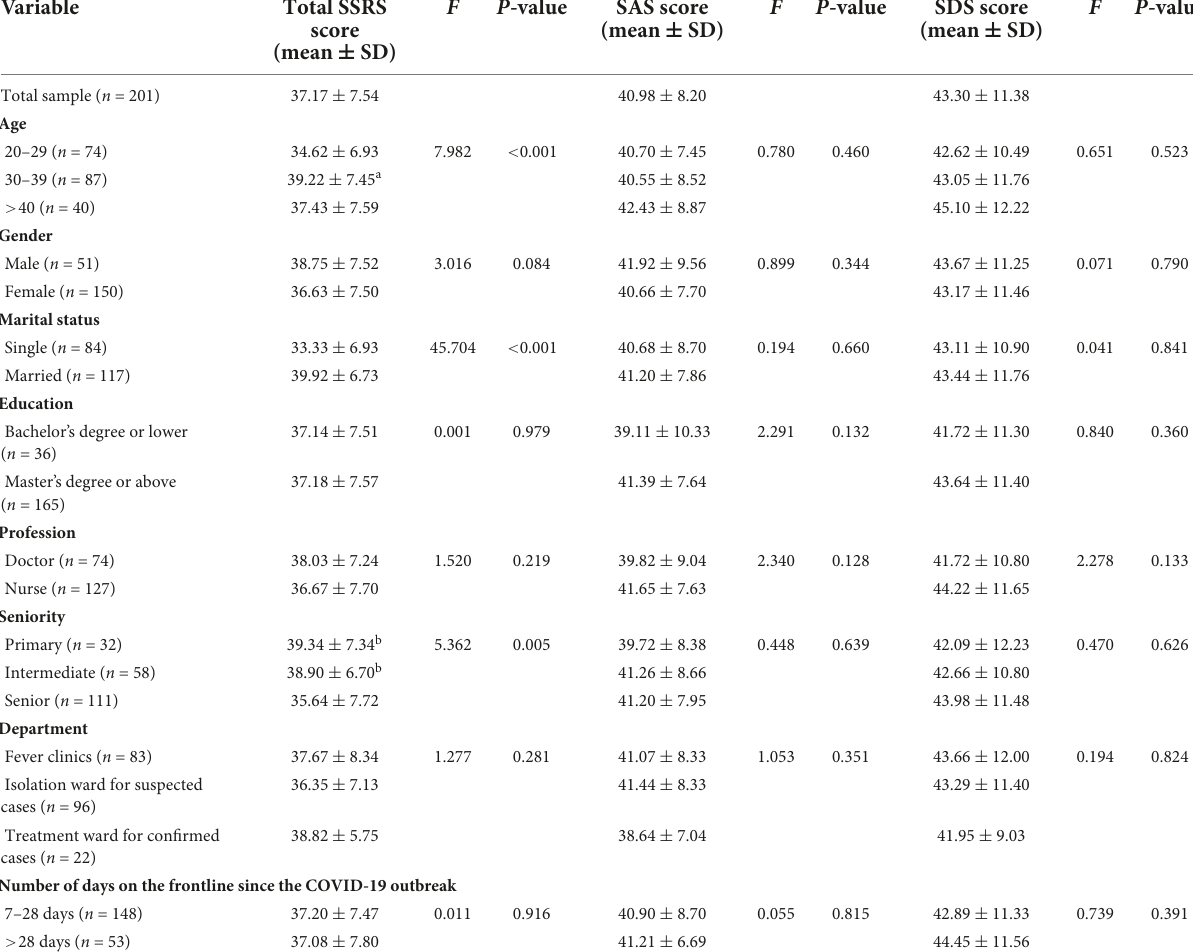
TABLE 3 Difference in total SSRS, SDS, and SAS based on demographic characteristics.